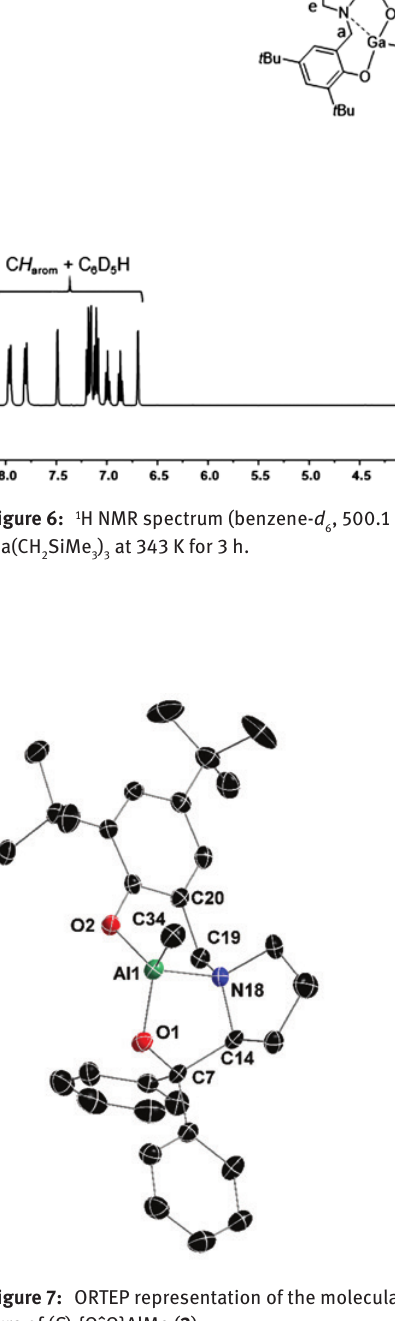
Figure 7: ORTEP representation of the molecular solid-state struc- ture of ( S )-{OˆO}AlMe ( 2 ). Ellipsoids drawn at the 50% probability level. H atoms and non- interacting toluene lattice molecule omitted for clarity. Selected bond lengths (Å) and angles ( ° ): Al1-O1 = 1.747(2), Al1-O2 = 1.763(2), Al1-C34 = 1.950(3), Al1-N18 = 2.0082; O1-Al1-O2 = 116.69(10), O1-Al1- C34 = 120.01(13), O2-Al1-C34 = 112.89(12), O1-Al1-N18 = 89.48(10), O2-Al1-N18 = 99.07(9), C34-Al1-N18 = 113.95(11).